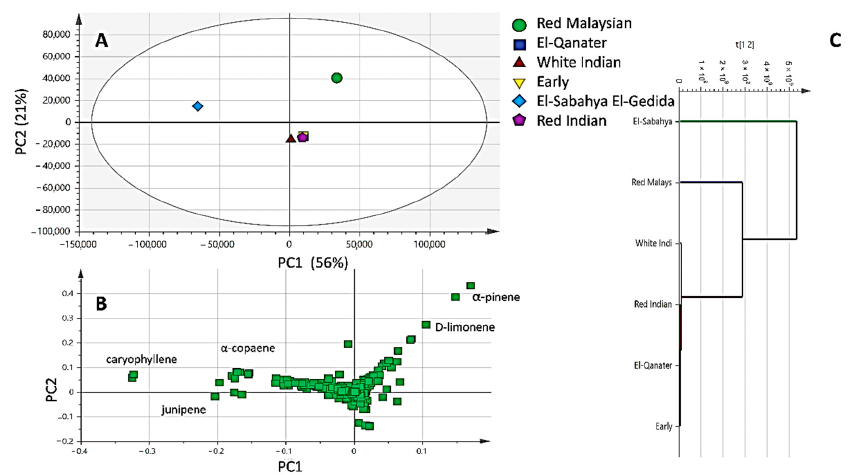
Figure 3. Principal component analysis ( A ) score plot, loading plot ( B ), and hierarchical clustering analysis ( C ). The model explains 77% of the total variance prescribed by principal components (PC1 and PC2).